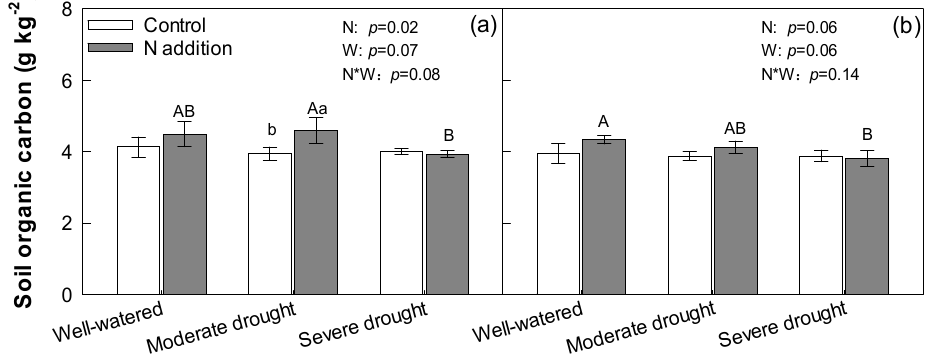
Figure 4. Soil organic carbon content in the 0–10 cm ( a ) and 10–20 ( b ) cm deep under different treatments. The error bar represented arithmetic means ± standard errors for three replicates. Different superscript indicates significant differences between N addition treatments under the same drought treatment (lowercase letters) and different drought treatments under the same N addition treatment (uppercase letters). * represents interactions.